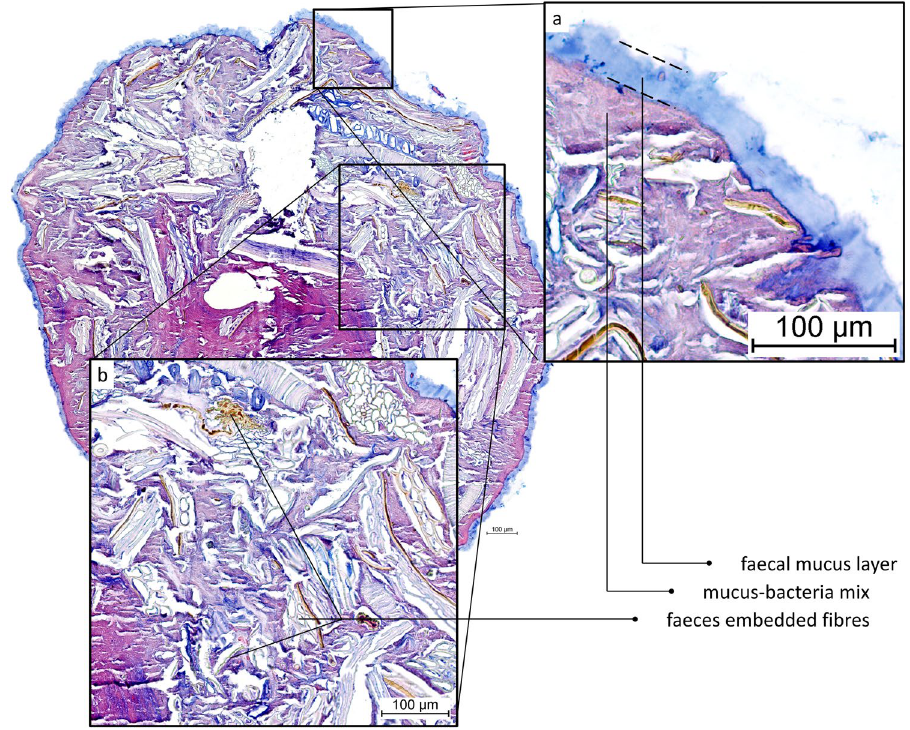
Figure 6. AB/H/E stained transversal cross-section of an expelled mouse faecal pellet. ( a ) A mucus layer devoid of bacteria covers the entire pellet. ( b ) Apart from alimentary residues and microbiota mixed with mucus, there are undigested plant fibres embedded in the faeces, as commonly observed in faecal matter in the gut as